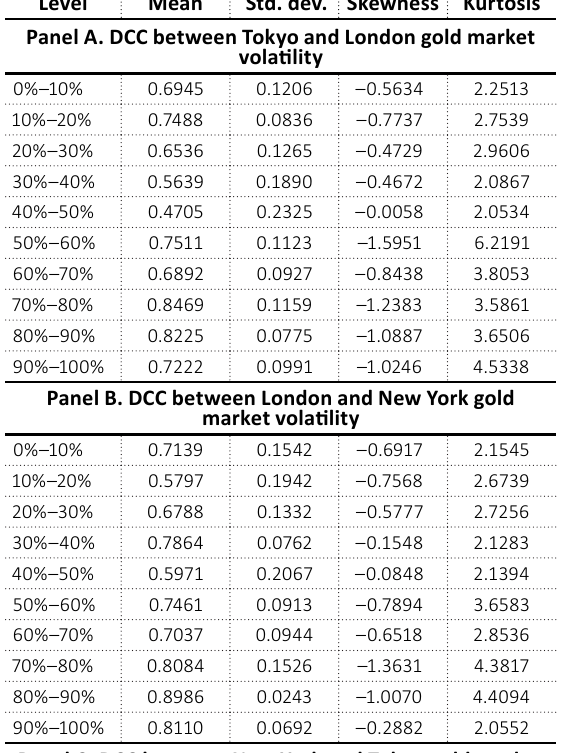
Table 2. The correlation of gold among Tokyo,